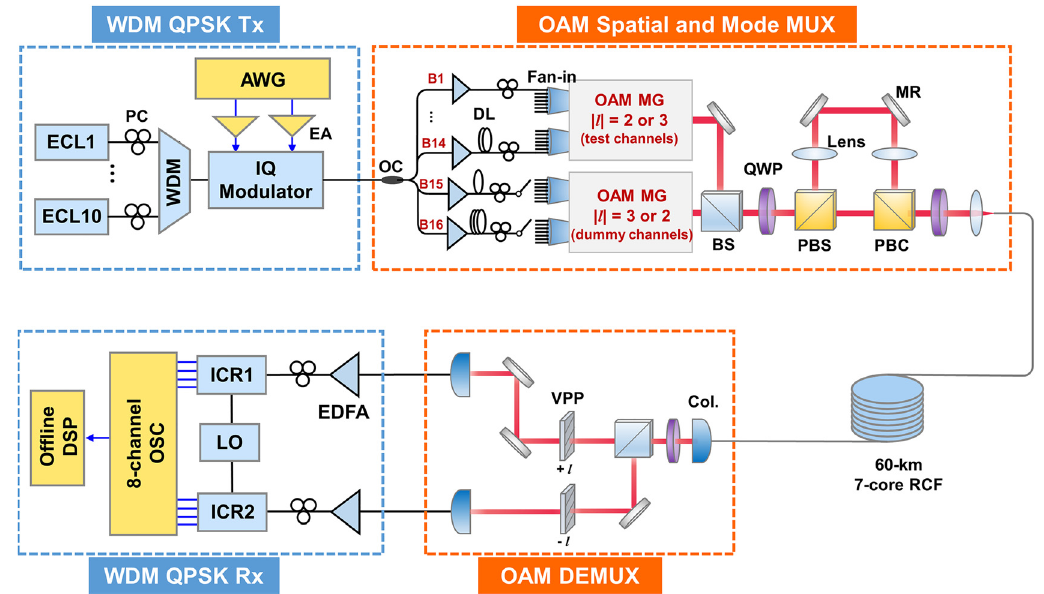
Figure 6: The experimental setup of the OAM-SDM – WDM data transmission system. WDM, wavelength division multiplexing, QPSK, quad- rature phase shift keying; AWG, arbitrary waveform generator; ECL, external cavity laser; EA, electric amplifier; OC, optical coupler; OAM, orbital angular momentum; MG, mode group; BS, beam splitter; MR, mirror; QWP, quarter-wave plate; PBS (PBC), polarization beam splitter (combiner). Col., collimator; RCF, ring-core fibre; VPP, vortex phase plate; EDFA, Erbium doped fibre amplifier; ICR, integrated coherent receiver; LO, local oscillator; OSC, oscilloscope; DSP, digital signal